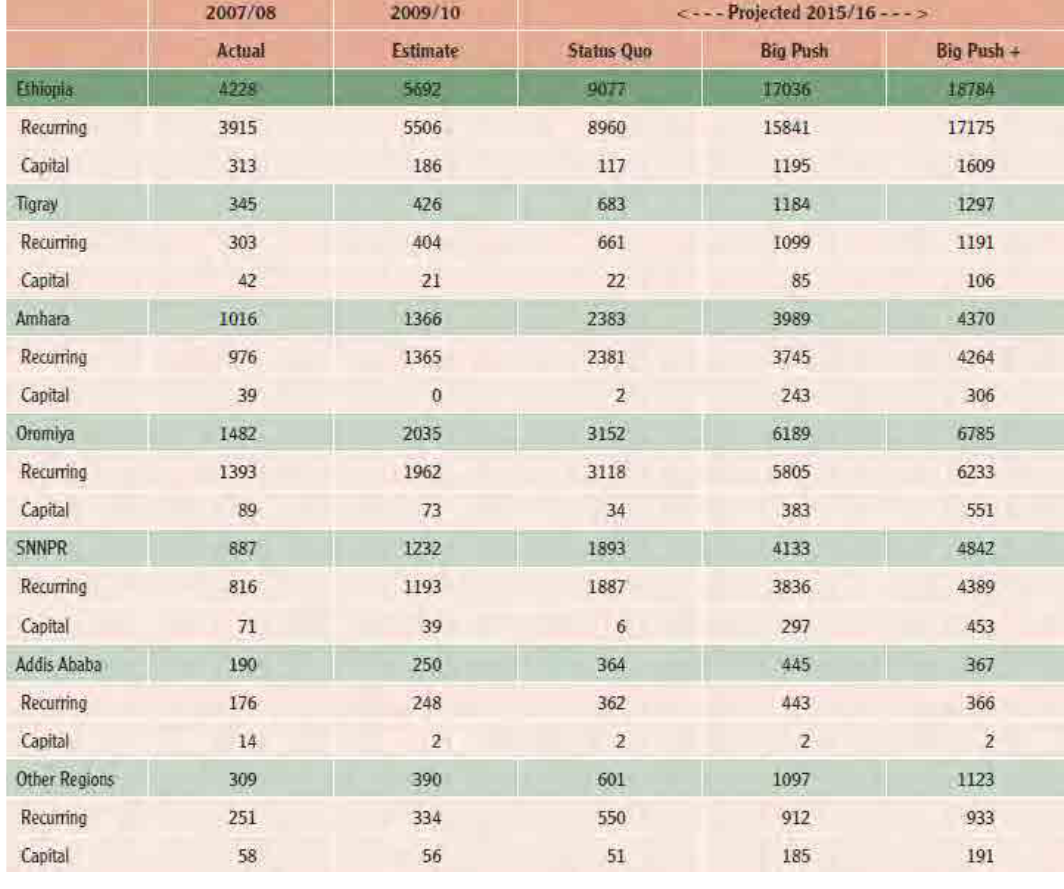
Table 5-6: Projected Expenditure on Public Primary Education (Annual Total) (2007/08